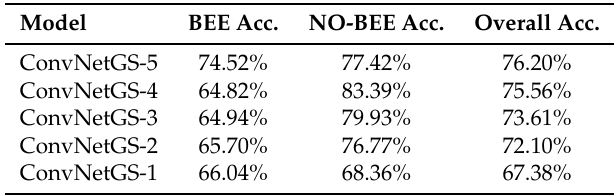
Table 5. Performance of five auto-designed ConvNets on BEE2_2S validation dataset. Each ConvNet was trained for 50 epochs. The number in the first column following the abbreviation ConvNetGS specifies the number of hidden layers. The validation accuracies are sorted from highest to lowest. The architecture of ConvNetGS-5 is given in Figure A3 in Appendix